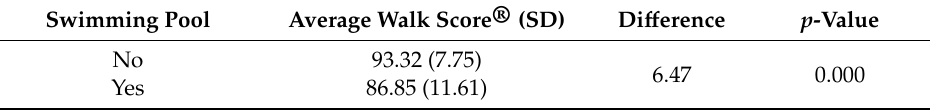
Table 5. Walk Score ® comparison in fitness centers with and without a swimming